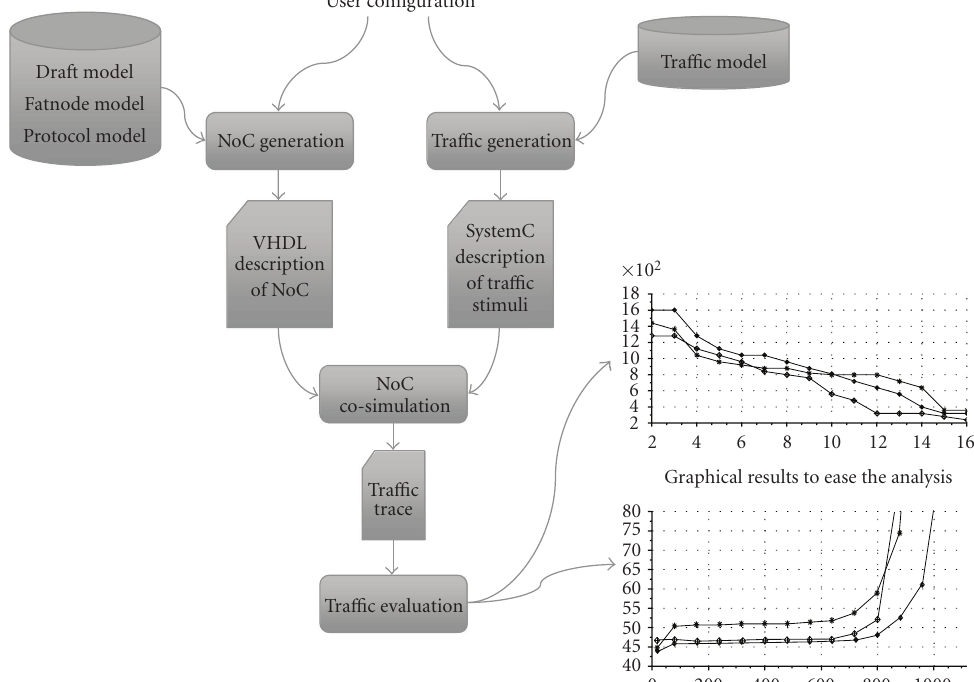
Figure 10: Conception flow of